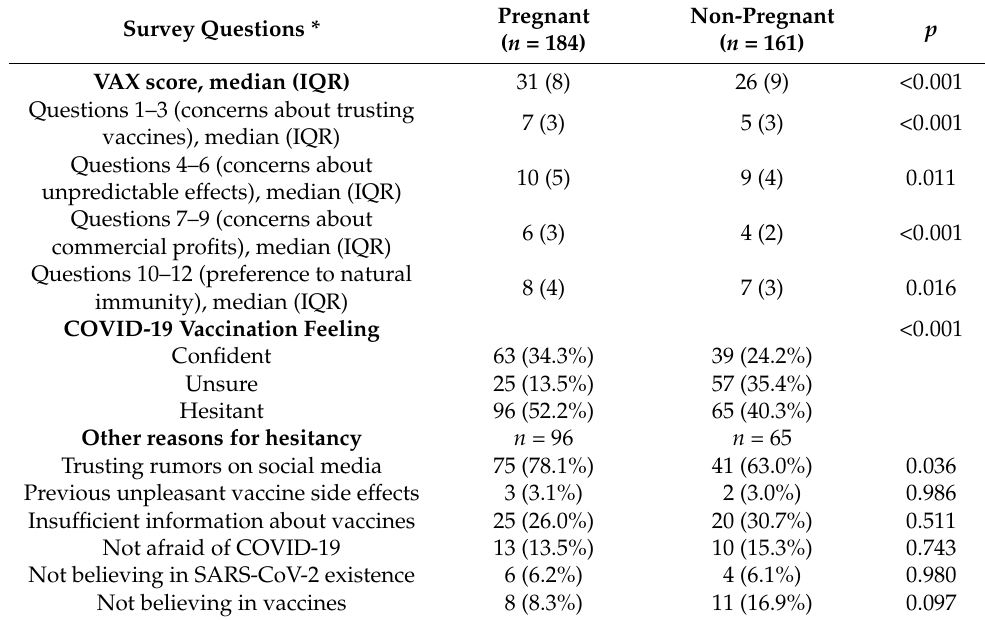
Table 2. VAX results and reasons for the hesitancy of the study participants.